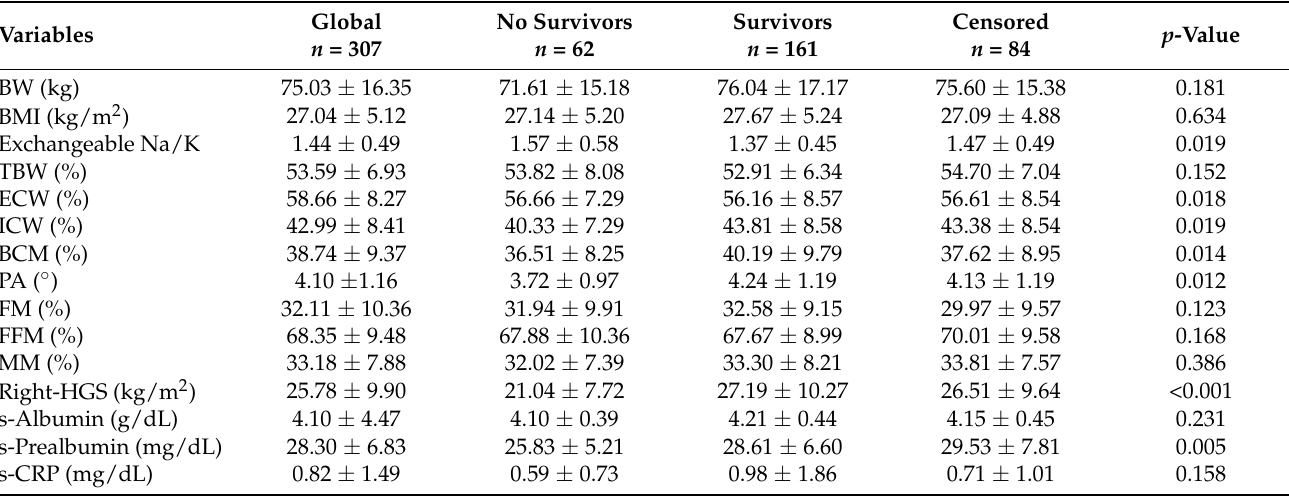
Table 2. Anthropometric, body composition, and laboratory parameters in 307 advanced chronic kidney disease